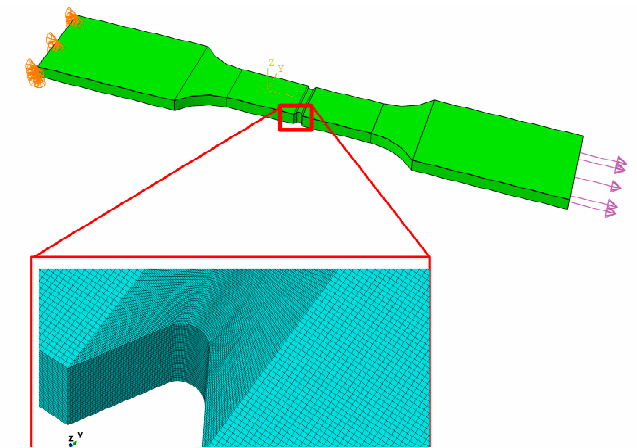
Figure 7. Finite element meshing, loading and constraining methods of notched specimens. Table 2. Stress concentration factor for all Q345qD notched